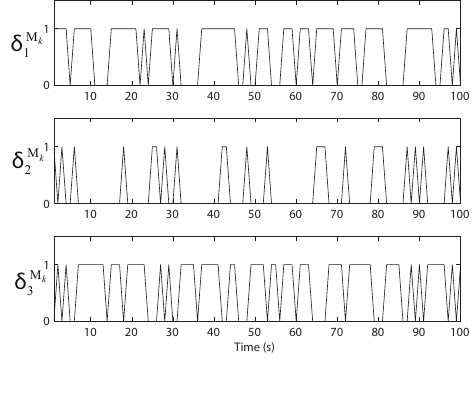
Figure 5. Measurement-loss functions with default transmission ranges of the sensor nodes with